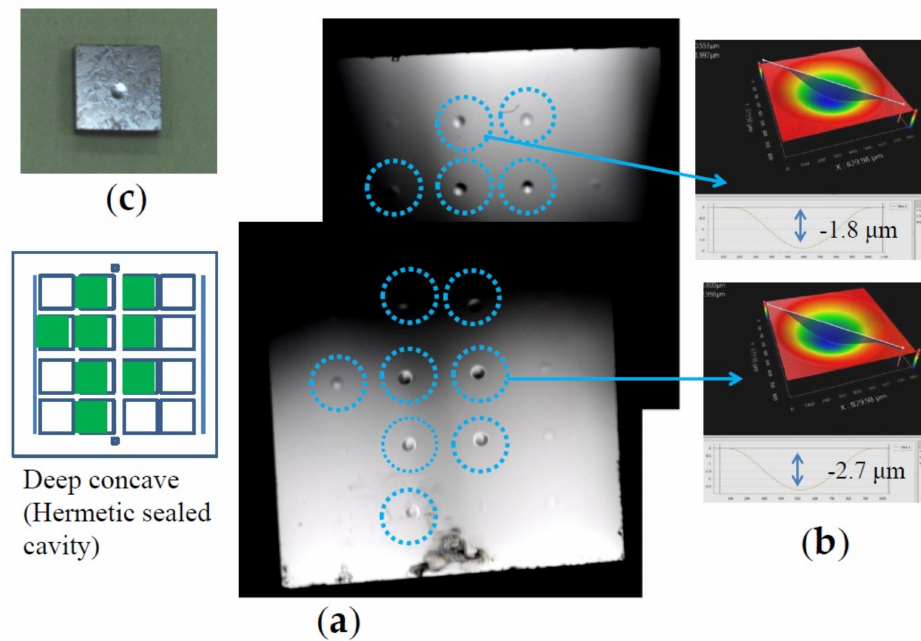
Figure 3. An example of bonded substrate pairs. ( a ) Surface photograph at 22 h after bonding and distribution of sealed dies in the substrate; ( b ) Typical diaphragm deformation of sealed die measured by white light interferometer; ( c ) Sealed die after dicing.